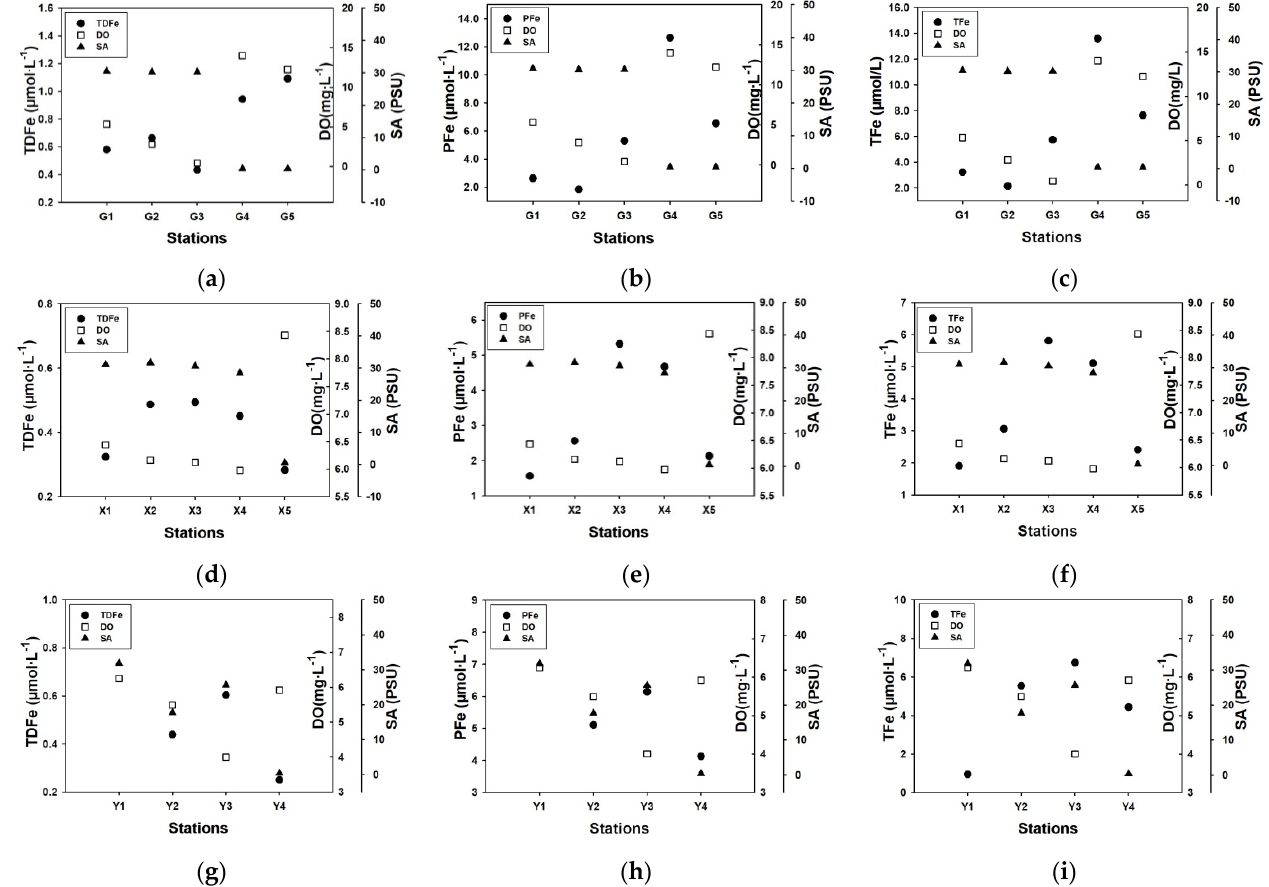
Figure 7. The relationships between different iron fractions and dissolved oxygen (DO) and salinity (SA) of water samples in Guangdang River ( a – c ), Xin’an River ( d – f ) and Yuniao River ( g – i ).